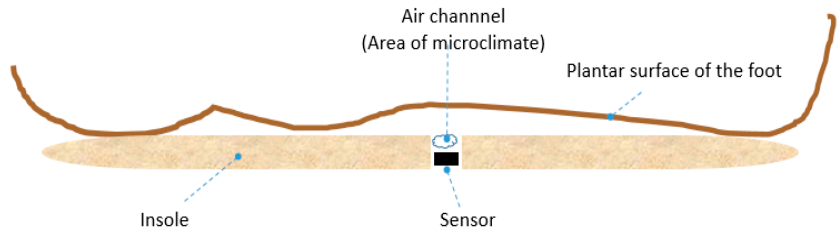
Figure 3. Representative scheme placing sensors in a circular hole in the insole, and the area where the air channel of the microclimate is created, between the plantar surface-insole and the sensor, to read the temperature and humidity.